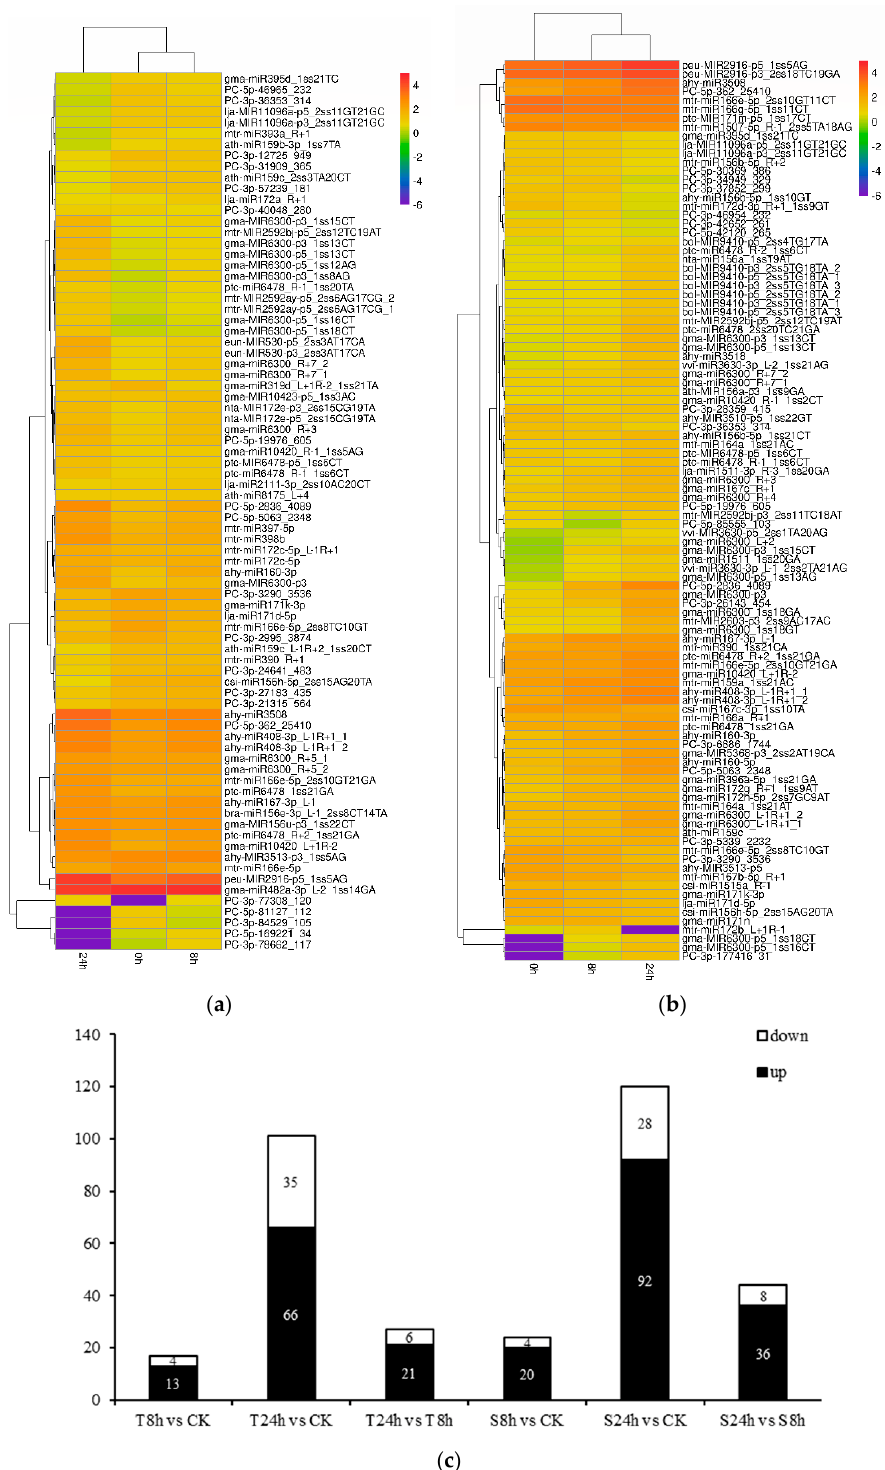
Figure 4. The numbers and expression profiling of differentially expressed miRNAs in root tips of peanut. Hierarchical clustering of differentially expressed miRNAs in 99-1507 ( a ) and ZH2 ( b ) at three different Al treatment periods (0, 8, and 24 h). Red indicates upregulated miRNAs, while purple indicates downregulated miRNAs. The original expression values of the miRNAs were normalized using Z-score normalization. The absolute signal intensity ranges from − 6.0 to +4.0, with corresponding color changes from purple to red. ( c ) The number of differentially expressed miRNAs under Al stress compared with the